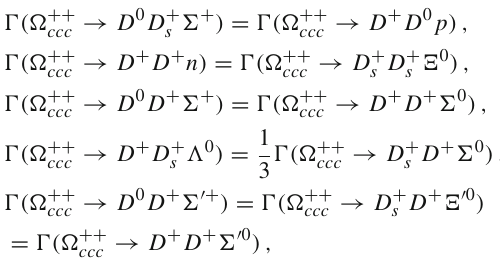
Table 1 Amplitudes for (cid:2) ++ ccc decays into two D -mesons and a light baryon (octet)